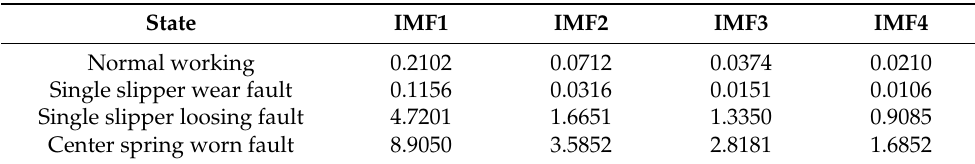
Table 4. Autoregressive (AR) spectrum energies of intrinsic mode function (IMF) components in different states.